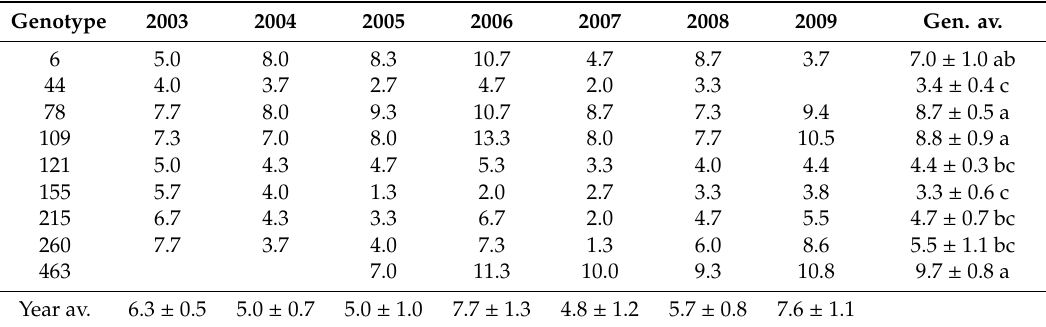
Table 7. Production (t Ha − 1 ) of Roda genotypes each